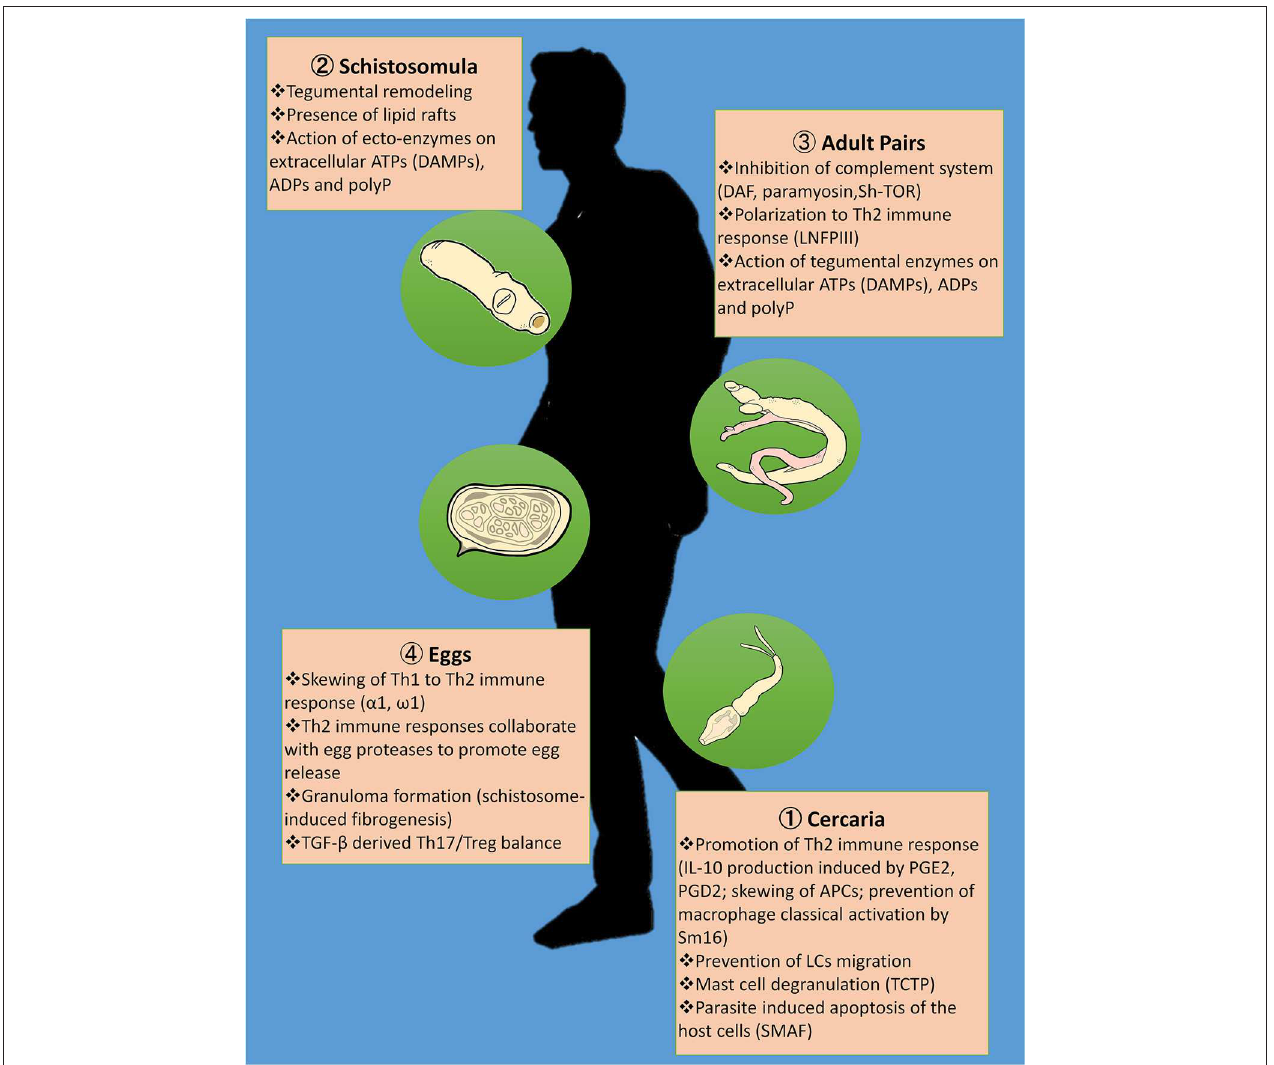
FIGURE 1 | Summary of proposed immunomodulatory strategies of the schistosome in evading the host immune responses. Skewing of Th1 to Th2 immune response is very much evident during cercarial penetration ‹ through IL-10 production induced by prostaglandin E2 (PGE2) and prostaglandin D2 (PGD2), prevention of macrophage classical activation by Sm16 and disorientation of the antigen presenting cells (APCs); lodging of the adult schistosome pairs in the veins fi through the interactions between lacto-N-fucopentose III (LNFPIII) and toll like receptors (TLRs); and egg deposition in the intestinal and liver tissues fl through the immunomodulatory effects of the egg’s excretory-secretory proteins (ES) to CD4 + effector responses including α 1 and ω 1. In addition, the cercariae ‹ are able to evade innate immunity in the skin by preventing migration of Langerhans cells (LCs), mast cell degranulation promoted by the translationally-controlled tumor protein (TCTP) homolog in schistosomes, and Schistosoma mansoni apoptosis-inducing factor (SMAF)-mediated host cell death. Schistosomula’s › tegumental remodeling and the presence of lipid rafts covering the parasite render them undetectable to immune responses during migration. Once the adult schistosomes fi settle in the mesenteric veins, they become capable of evading the host complement system through the abstraction of erythrocytes’ decay-accelerating factor (DAF) as seen in in vitro studies, the binding of human complement C8 and C9 to the schistosome’s paramyosin, and the attachment of C2 to the trispanning orphan receptor of Schistosoma haematobium (Sh-TOR). Ecto-enzymes on the tegument of intravascular stages including the › schistosomula and fi adults cleave extracellular ATPs that otherwise serve as damage-associated molecular patterns (DAMPs) as well as ADPs and inorganic polyphosphates (polyPs), thereby interfering with host pro-inflammatory and prothrombotic purinergic signaling. Eggs from the schistosomes in copula fl express proteases that may aid in egg egress in addition to Th2 immune responses. Granuloma formation with schistosome-induced fibrogenesis tends to limit tissue destruction brought about by egg deposition. However, disease severity is largely determined by Th17/Treg balance mediated by transforming growth factor- β (TGF- β